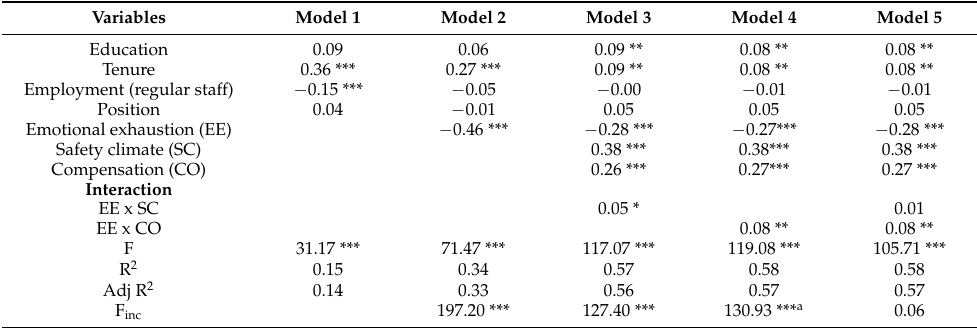
Table 4. Hierarchical multiple regression for job satisfaction.